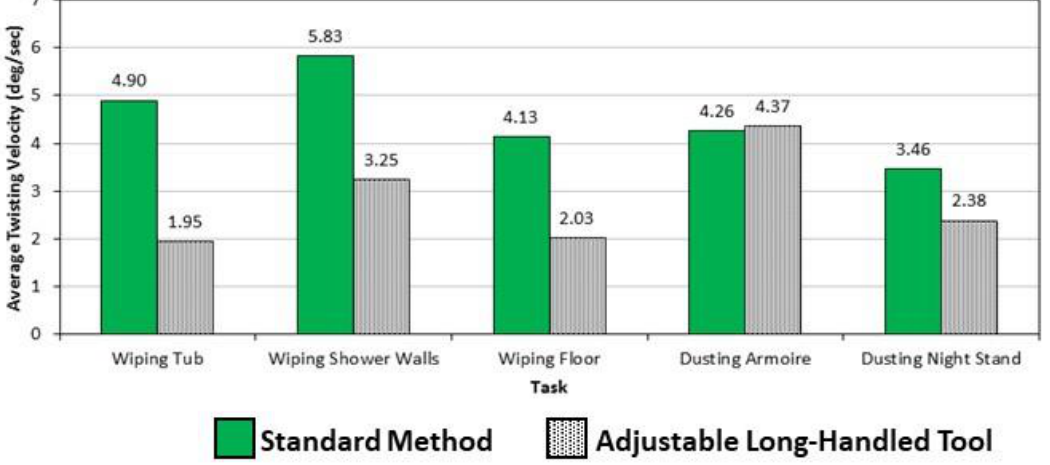
Figure 6. Differences in average transverse trunk velocities between cleaning methods of five bathroom and furniture cleaning methods. Only the bathroom tasks were significantly different ( p < 0.05).